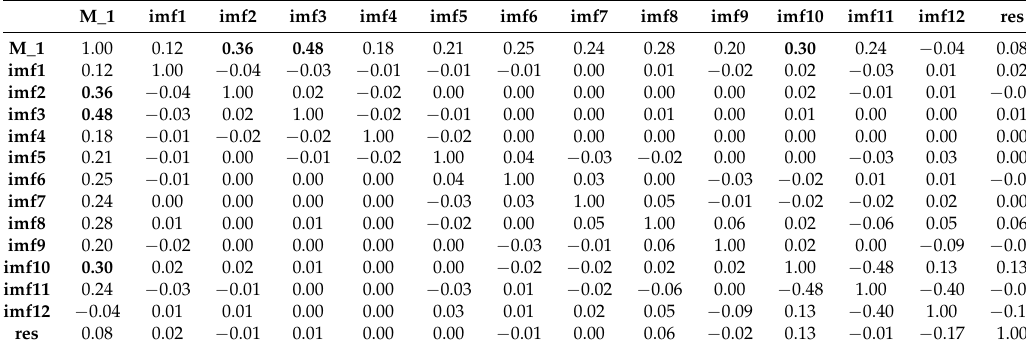
Table A1. M_1 load component correlation coefficient table.